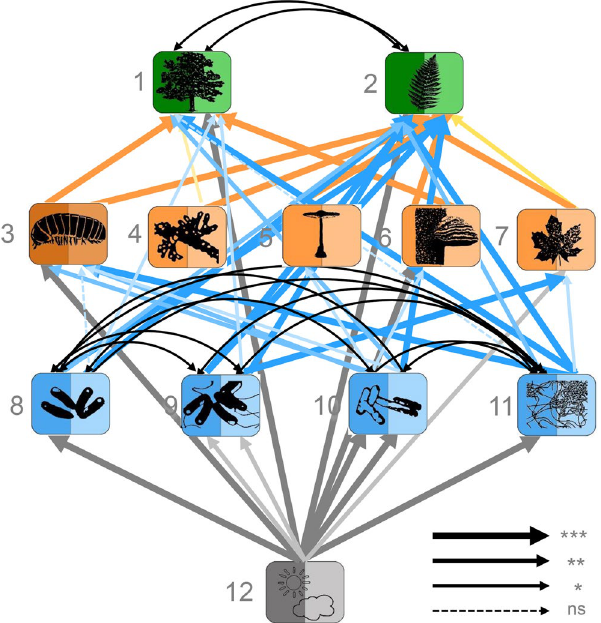
Figure 1. Top-down control in the belowground community web. Structural equation model across trophic levels based on community structure, represented for each organism group by the first two axes of principal components analyses (PC1: darker shade, PC2: lighter shade) on species identities and relative abundances ( χ ² = 132.4, P = 0.127, DF = 115, RMSEA = 0.075, P-value RMSEA = 0.266, AIC = − 1470.4, N = 27). Relationships are controlled for environmental dependencies, scaled proportional to their significance ( *** P ≤ 0.001; ** P ≤ 0.01; * P ≤ 0.05; ns nonsignificant). For clarity, only covariances ≤ 0.01 are plotted. See Supplementary Table S3 for detailed model ouput with path coefficients and error terms, and Fig. S4 for an alternative presentation. Colors of boxes and corresponding arrows indicate different trophic or functional groups. Groups are: tree layer plants (1), herb layer plants (2), macrofaunal decomposers (3), arbuscular mycorrhizae (4), ectomycorrhizae (5), saprophytic fungi (6), pathogenic fungi (7), Acidobacteria